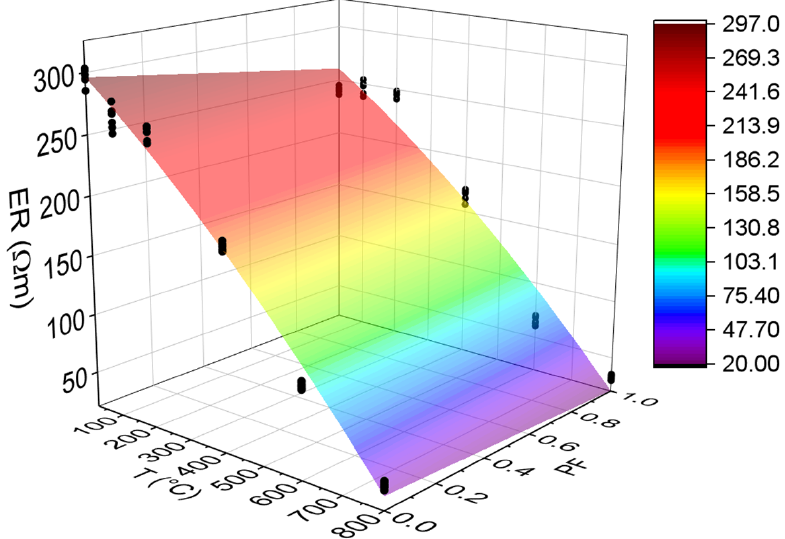
Figure 15. Quadratic multiple regression model fitting for electrical resistivity estimation.